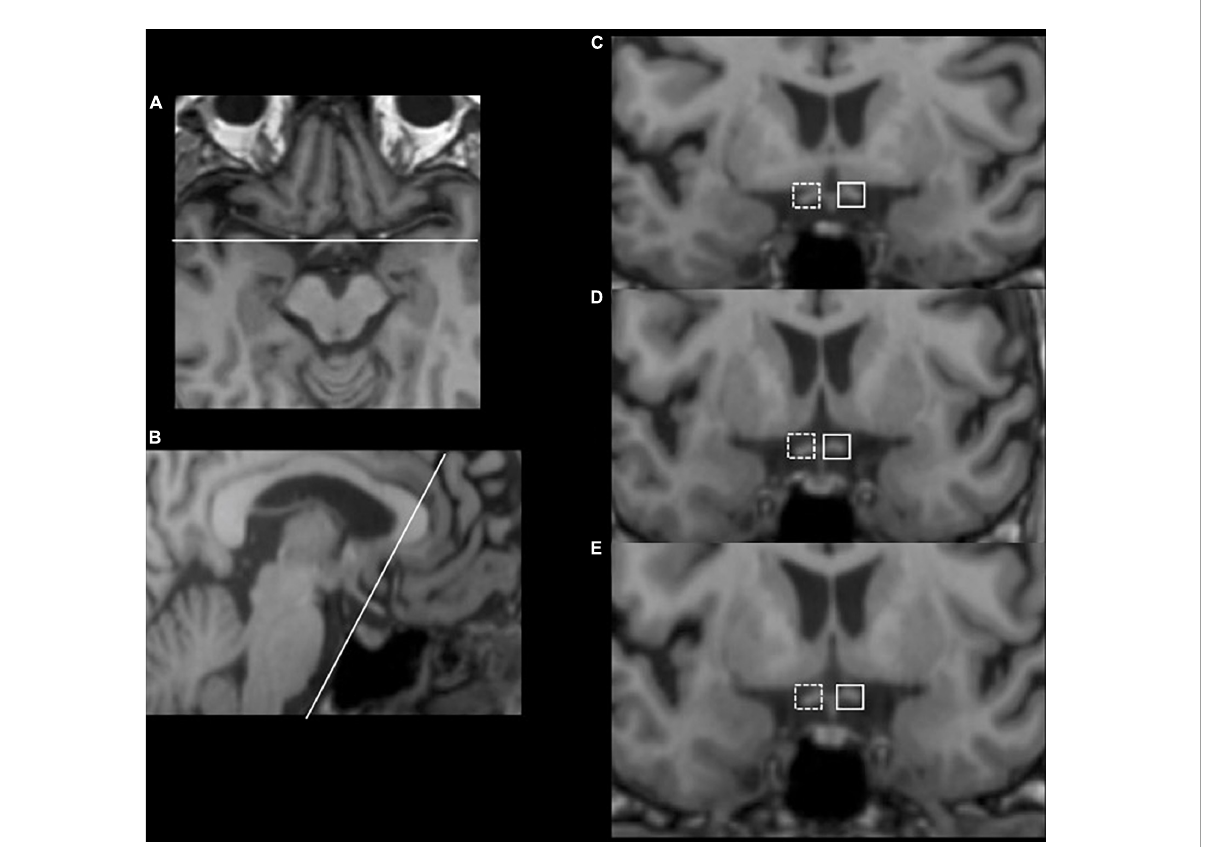
FIGURE1 Illustration of optic tract measurements with an example from a 56-year-old female thalamus stroke patient. Consecutive (C–E) coronal slices, which have been resliced and reoriented to be perpendicular to the OT (B) , were obtained starting with three slices posterior to the beginning of the optic chiasm (A) . Equal-sized masks were hand-drawn on the two sides of optic tracts in each slice, with the solid border as the contralateral side and the dashed border as the ipsilateral side.